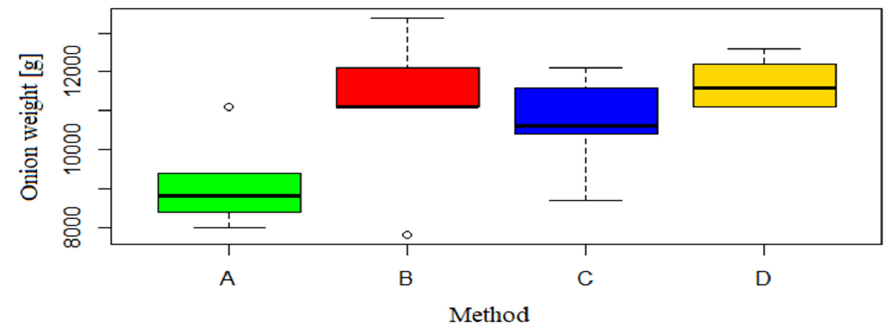
Figure 12. Weight of all onions harvested from the plots.